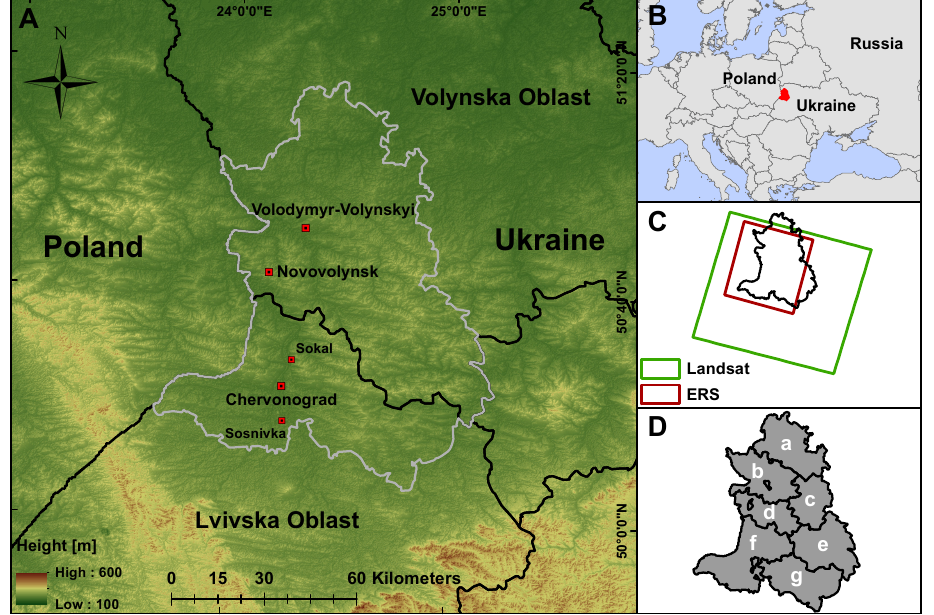
Figure 1. Map of the study area in western Ukraine. ( A ) Study area boundaries (grey); ( B ) Location of the study area in Europe; ( C ) Landsat footprint (green) and ERS footprint (red); ( D ) Administrative boundaries of (a) Turiyskyi Raion; (b) Volodymyr-Volynskyi Raion; (c) Lokachynskyi Raion; (d) Ivanychivskyi Raion; (e) Horokhivskyi Raion; (f) Sokalskyi Raion; and (g) Radekhivskyi Raion.